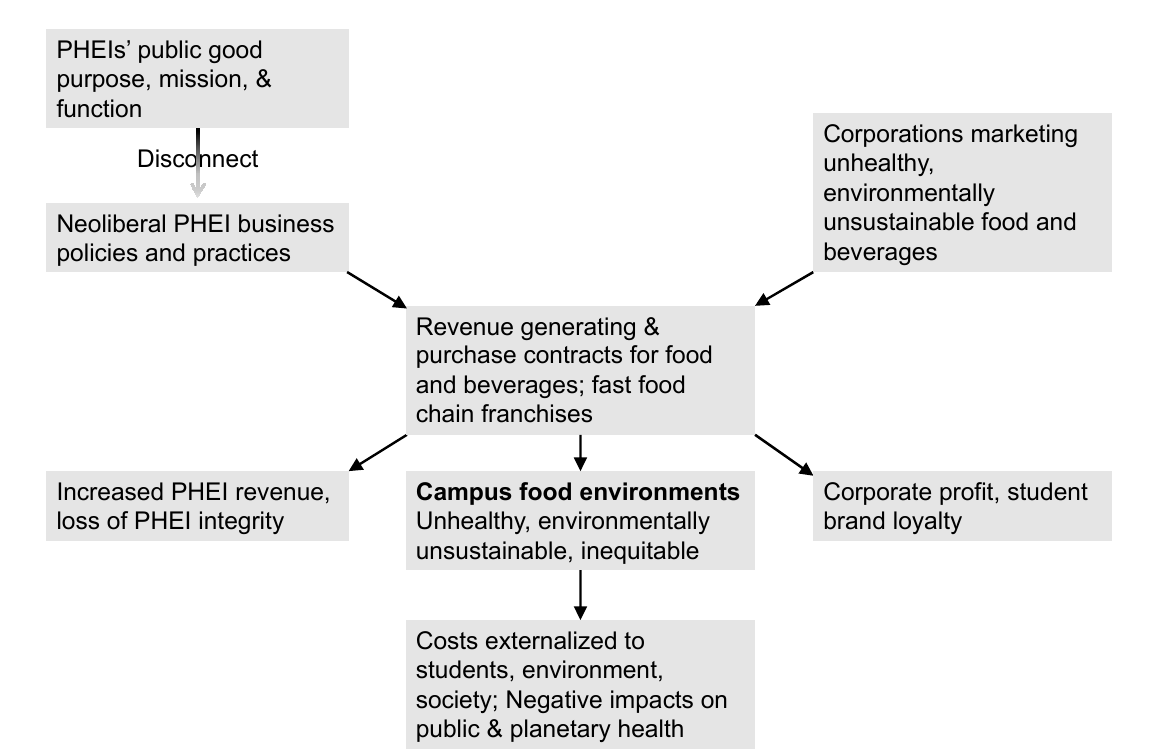
Figure 5. PHEI neoliberal policies drive unhealthy campus food environments and externalize negative impacts. © D.A. Cleveland, used with permission.